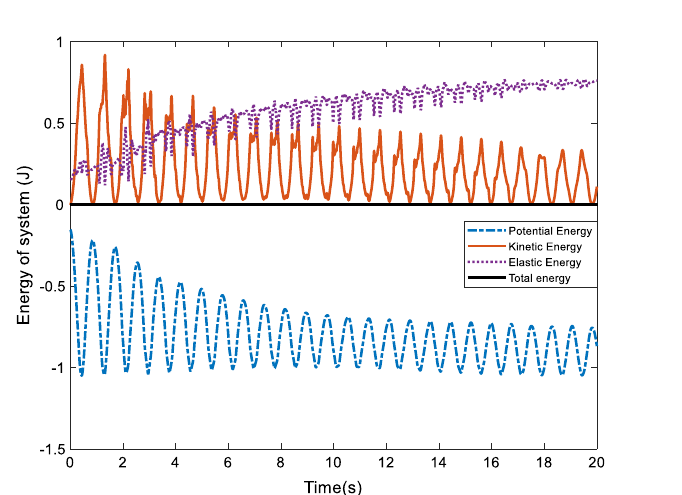
Figure 6. System energy analysis.